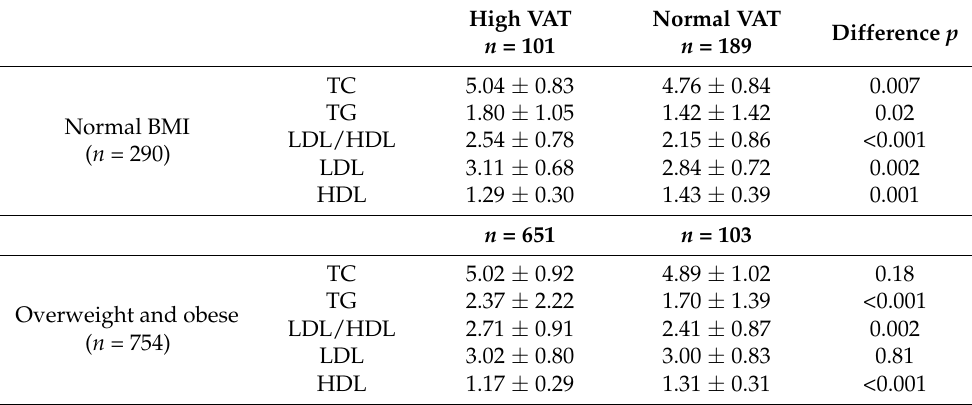
Table 5. Lipid profiles of Chinese men ( n = 1044) according to BMI and visceral fat.